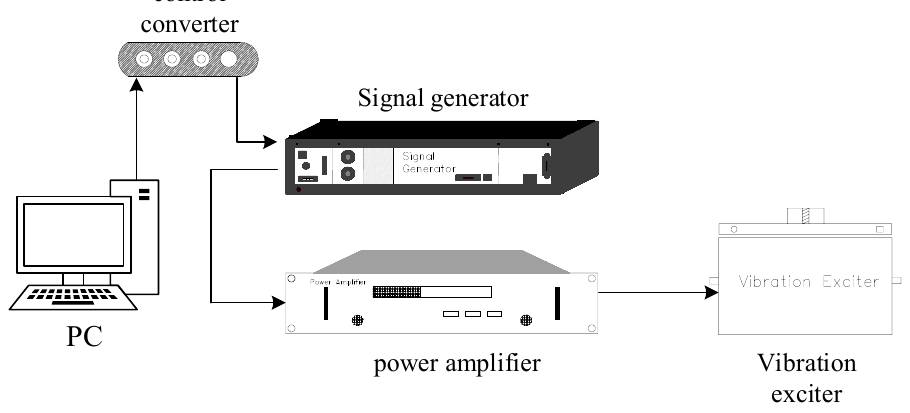
Figure 6. Simple schematic diagram of the test platform.